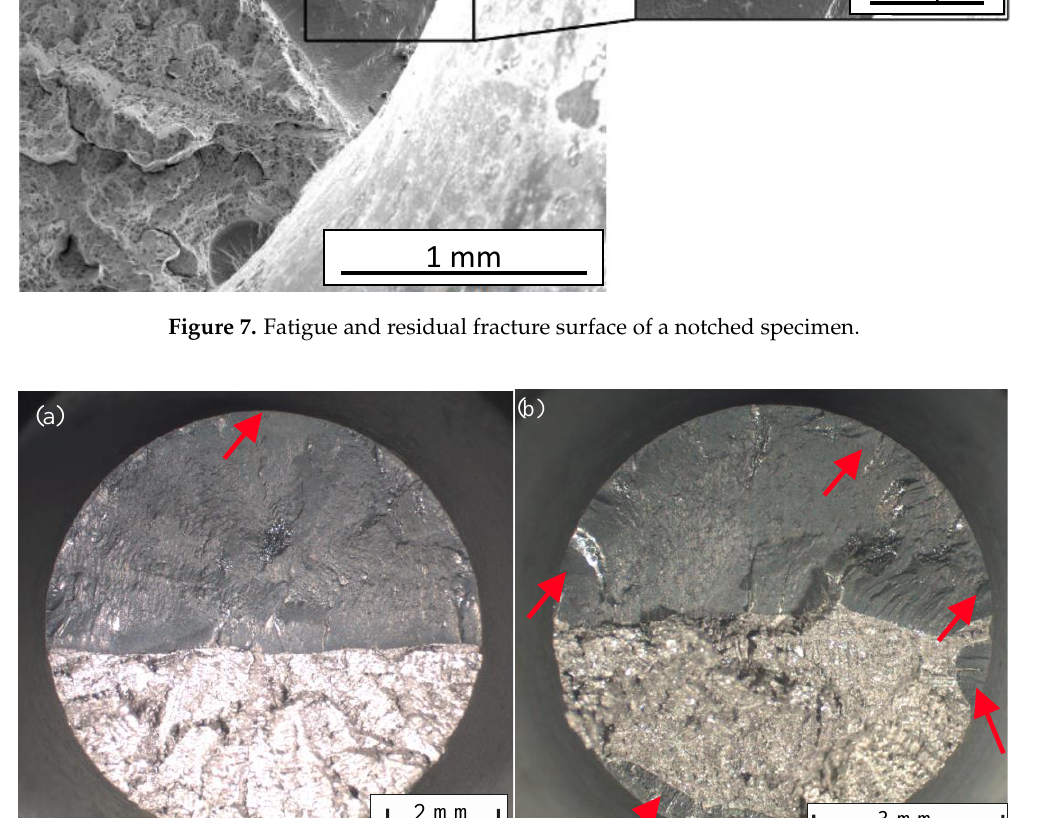
Figure 7. Fatigue and residual fracture surface of a notched specimen.